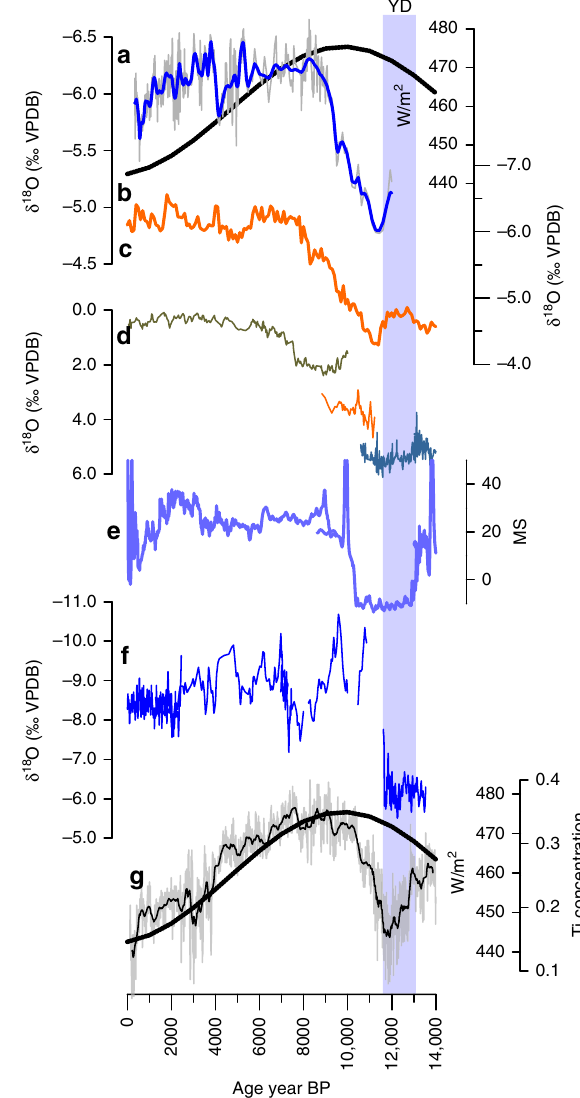
Fig. 2 Comparison of Central American and regional rainfall